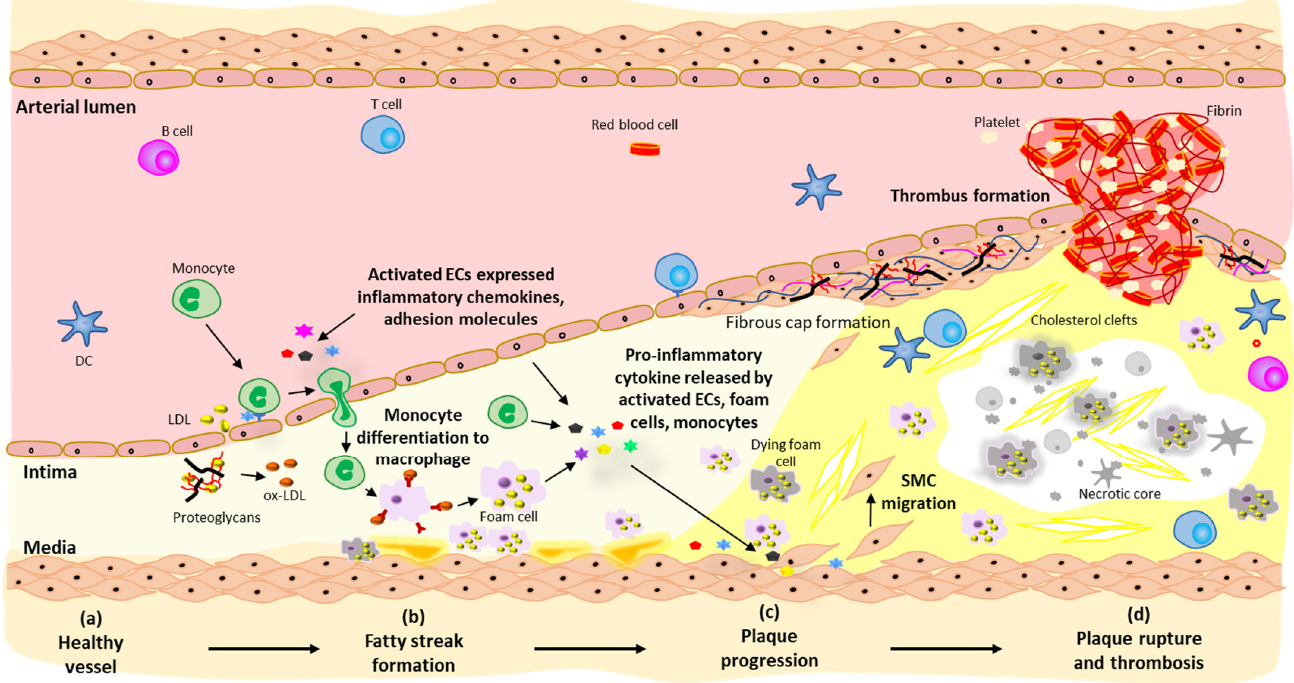
Figure 1. Pathogenesis of atherosclerosis. ( a ) Normal structure of an artery with an intact endothe- lium separating the arterial wall from the circulating blood. ( b ) Endothelial dysfunction in response to increased cardiovascular risk factors (e.g., hyperlipidemia, hyperglycemia, hypertension) com- promises its restrictive barrier function, allowing the enhanced entry of low-density lipoprotein (LDL) into the arterial intima where it can become trapped through binding to the ECM, increasing the susceptibility of LDL to oxidative modification. Activated ECs also express proinflammatory adhesion molecules and chemokines, which facilitate monocyte recruitment into the arterial intima and their differentiation into macrophages. The excessive uptake of lipids from modified LDL results in the formation of foam cells, marking the formation of early fatty streak lesions. ( c ) Recruited monocytes/macrophages and the activated, dysfunctional endothelium release cytokines and growth factors, which stimulate the migration and proliferation of medial vascular SMCs. These ‘synthetic’ SMCs secrete large amounts of ECM (primarily collagen) to form a subendothelial fibrous cap